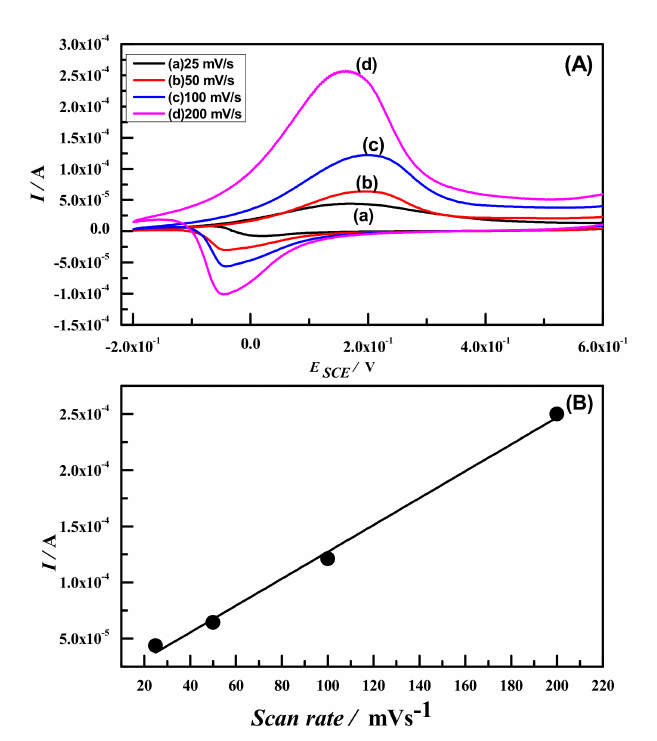
Figure 6. ( A ) CV curves of PACHA coated gold electrode recorded in 1.8 M NaOH + 5 M CH 3 OH at 25, 50, 100, and 200 mV/s; ( B ) plot of anodic peak current versus scan